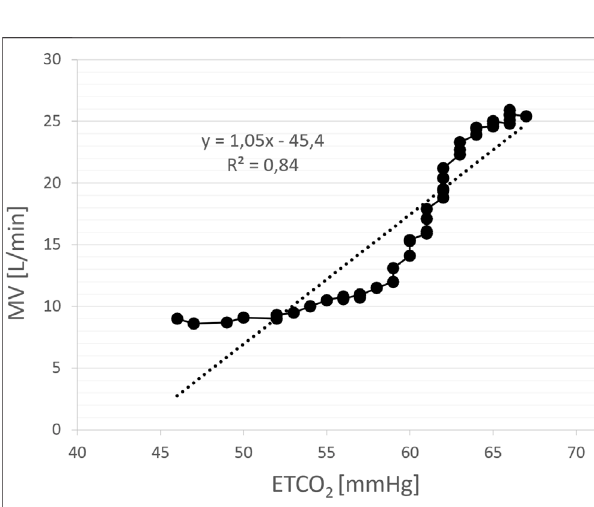
FIGURE 6 | An example of the assessment of hypercapnic ventilatory response (HCVR) using rebreathing method. The slope of the regression line relating minute ventilation (MV) to end-tidal CO 2 (ETCO 2 ) constitutes a measure of HCVR (L/min/mmHg). Each solid point represents a single